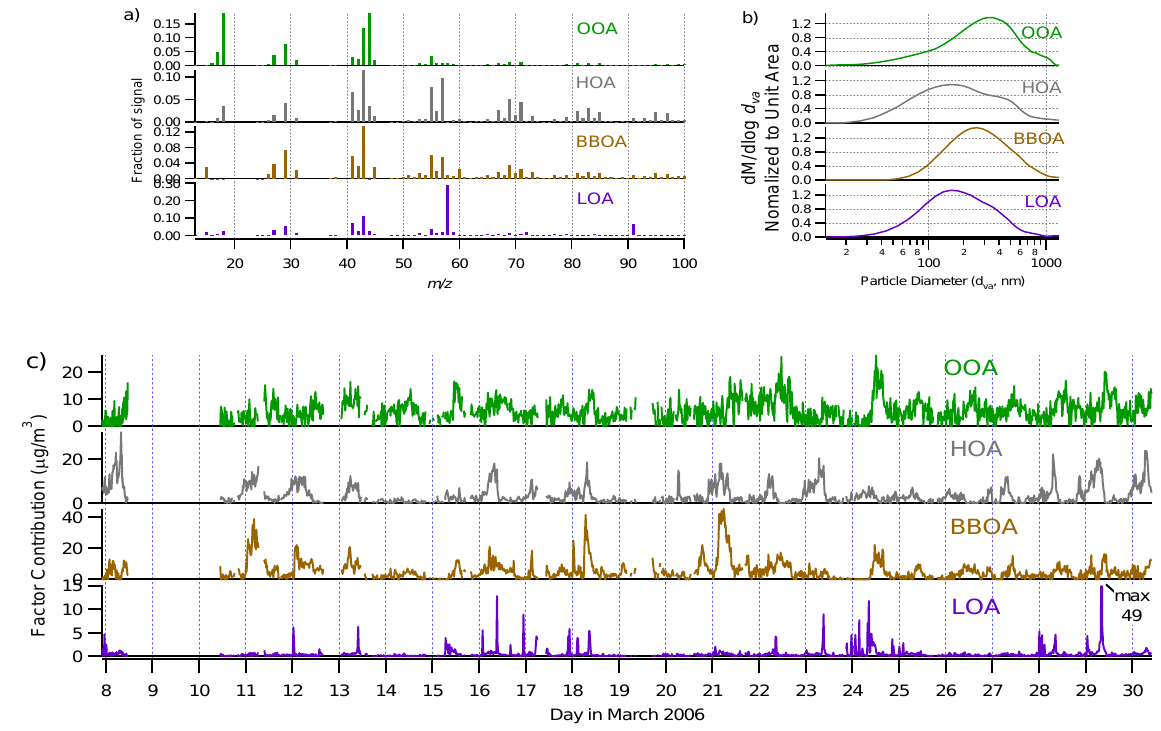
Fig. 4. The best 3-vector solution, which has four factors, solved with ME-2. The four factors are oxidized organic aerosol (OOA), hydrocarbonlike organic aerosol (HOA), biomass-burning organic aerosol (BBOA), and local organic aerosol (LOA). (a) Mass spectrum of each factor, normalized to sum to 1. (b) Mass size distribution (d M /dlog d va ), normalized to unit area. (c) Mass contribution of each factor. The scale for LOA has been expanded to show the structure during low-concentration